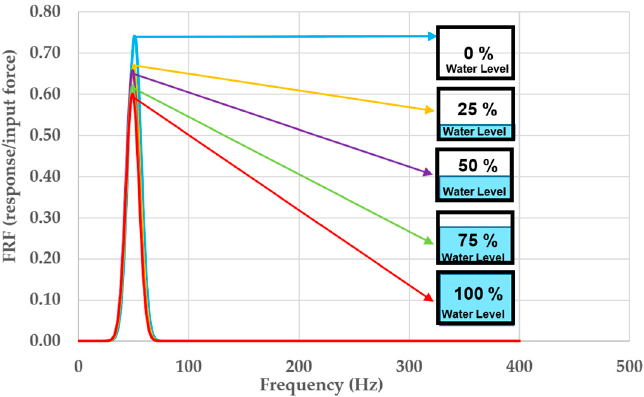
Figure 13. Chart of frequency response function (FRF).